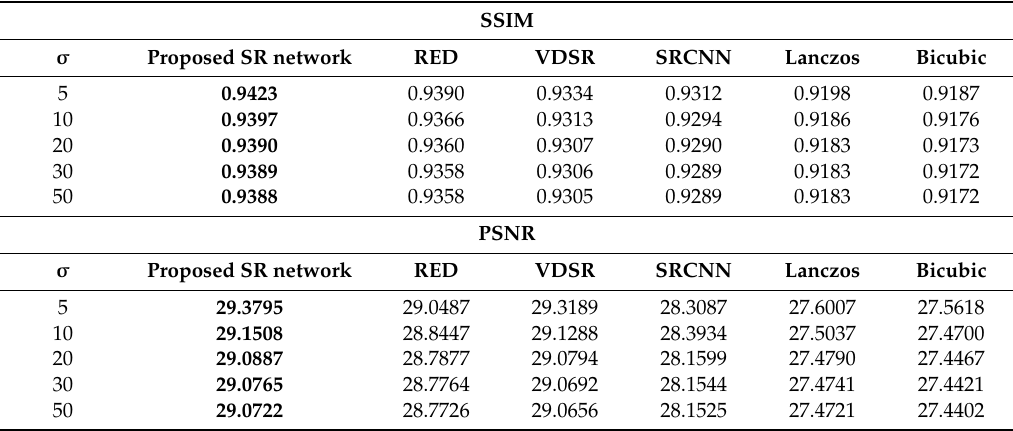
Table 2. Average peak signal-to-noise ratio (PSNR) and structural similarity index (SSIM) in di ff erent standard deviations σ of gaussian